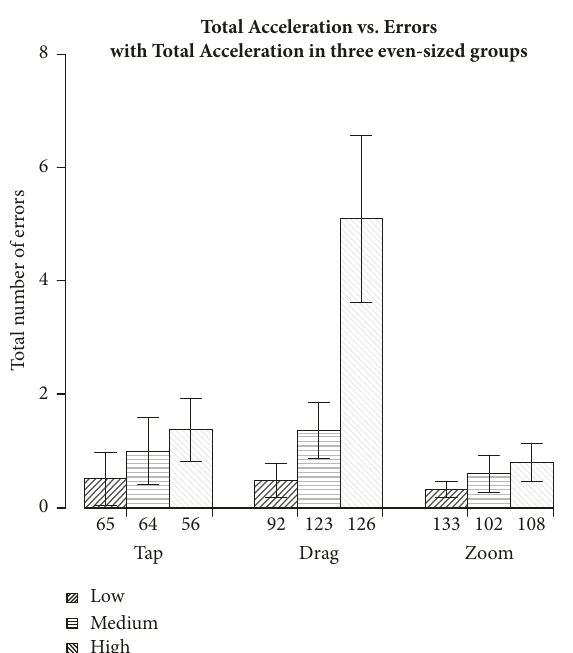
Figure 23: Completion time for the three task types depending on RMS of angular speeds ( ∘ /s) for G0 (pitch).The numberof samples is provided below the histograms. Horizontal bars denote the average time to first